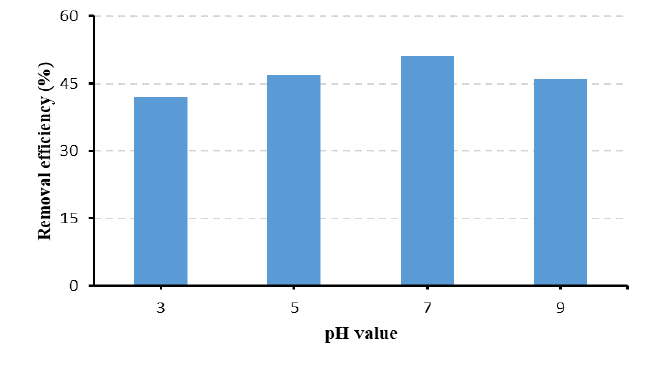
Fig. 3. Effect of the initial pH on COD